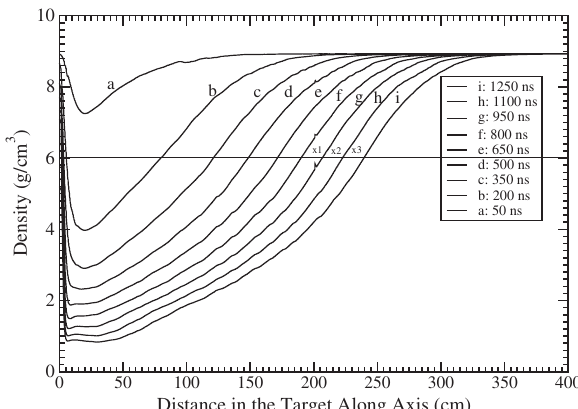
FIG. 12. Density on the axis vs distance in the target at different times, calculation of the penetration distance of the FCC beam in a solid copper